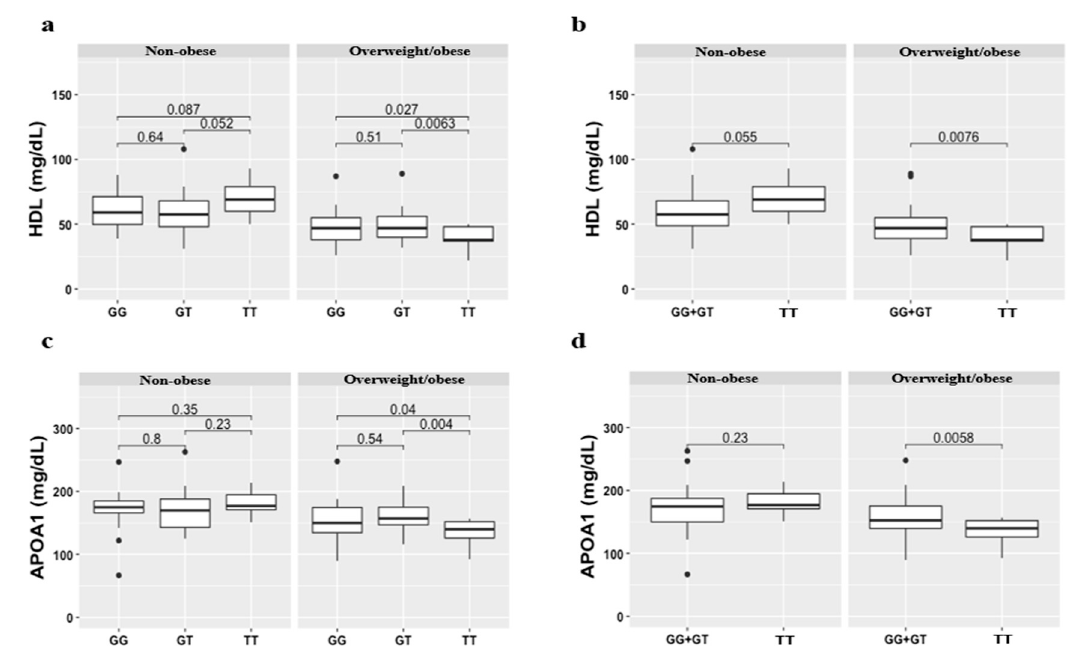
Figure 1. High density lipoprotein (HDL) and APOA1 levels according to the APOA2 rs3813627 genotypes in non-obese and overweight / obese individuals. ( a , b ) Representation of HDL levels according to the APOA2 rs3813627 genotype in non-obese ( n = 62) (BMI < 25 kg / m 2 ) (GG = 26, GT = 26, GG + GT = 54, and TT = 10) and overweight / obese ( n = 91) (BMI ≥ 25 kg / m 2 ) individuals (GG = 41, GT = 37, GG + GT = 78, and TT = 13); ( c , d ) Representation of APOA1 levels according to the APOA2 rs3813627 genotype in non-obese ( n = 52) (GG = 21, GT = 23, GG + GT = 44, and TT = 8) and overweight / obese individuals ( n = 65) (GG = 27, GT = 25, GG + GT = 52, and TT = 13). Results are presented as means ± S.D. p -value indicates significant di ff erence between genotypes according to Welch’s two sample t -test ( p < 0.05). Abbreviations: HDL, high density lipoprotein; APOA1, apolipoprotein type A1; APOA2, apolipoprotein type A2.